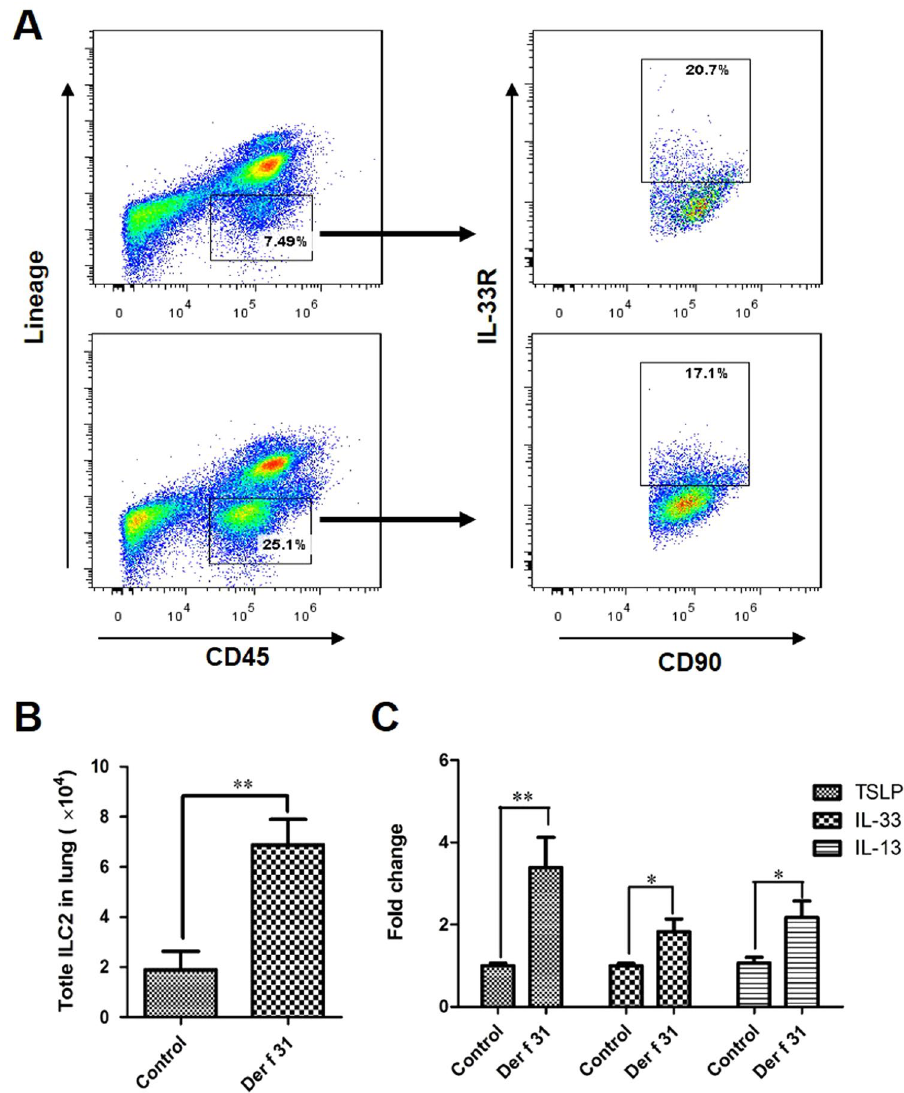
were generated from one of three experiments (n = 4–6) and processed with GraphPad software. The significant differences between two groups were tested by two-tailed T-test. * p < 0.05. ** p <